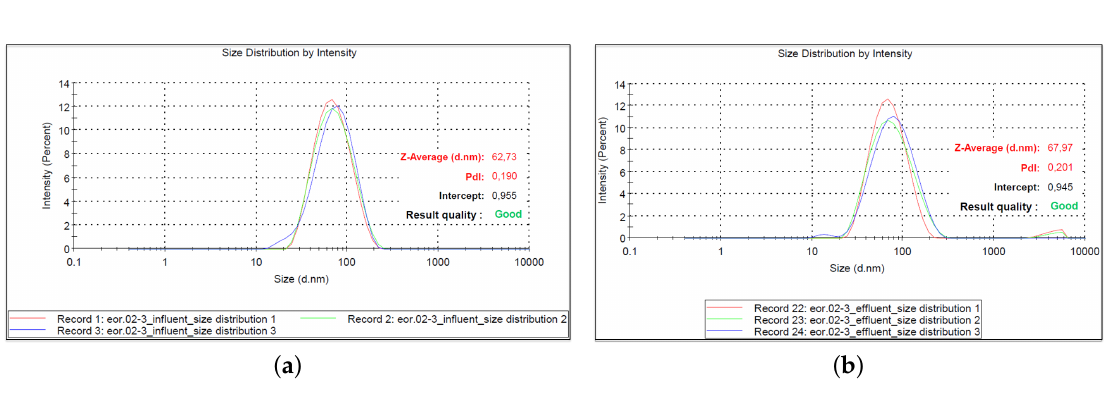
Figure 8. Nanoparticle size distribution curves for sample NF1 at 0.1 wt %: ( a ) influent; and ( b )